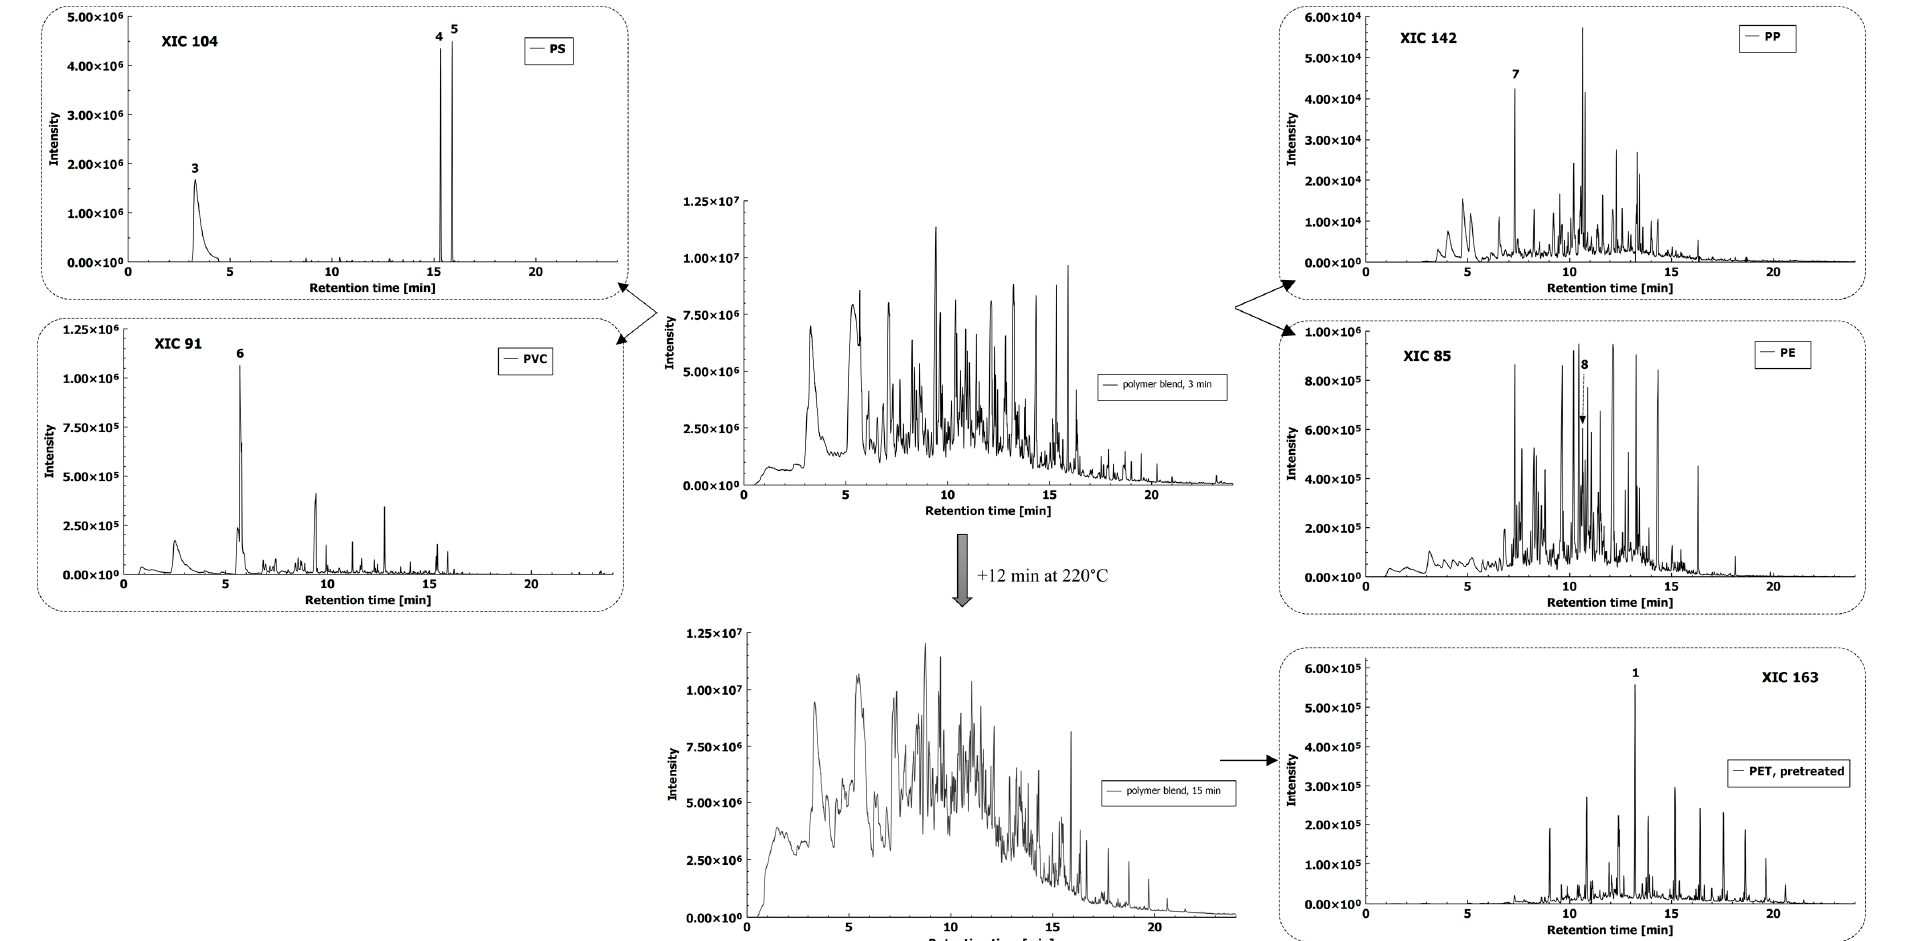
Figure 6. Total ion chromatograms of polymer blend after thermal decomposition at 220 °C for 3 min and 15 min with extracted ion chromatograms of PS (3-styrene, 4 and 5-trans (cis)-1,2-diphenylcyclobutane, PVC (6-1-chlorooctane), PP (7-4,6-dimethyl 2-heptanone), PE (8-pentadecane), and PET (1-dimethyl terephthalate)).